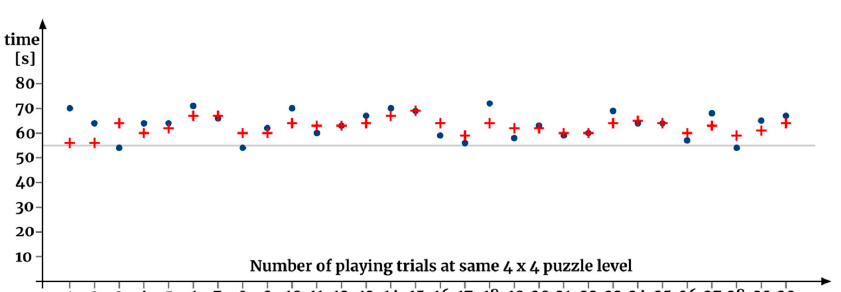
Figure 3. Adaptation of time frames according to level completion time for player type 1. Blue dots represent the level completion time; red crosses represent time frames adapted to the player.